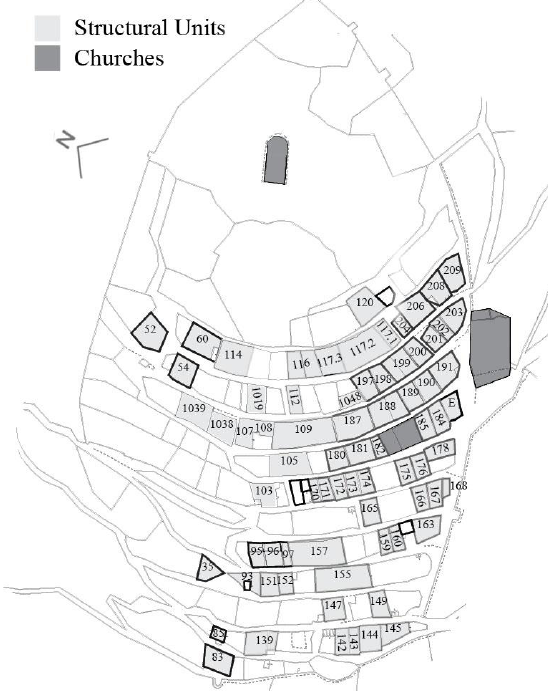
Figure 2. Identification of the Structural Units (SUs) in the case study according to the Gregorian cadastre.